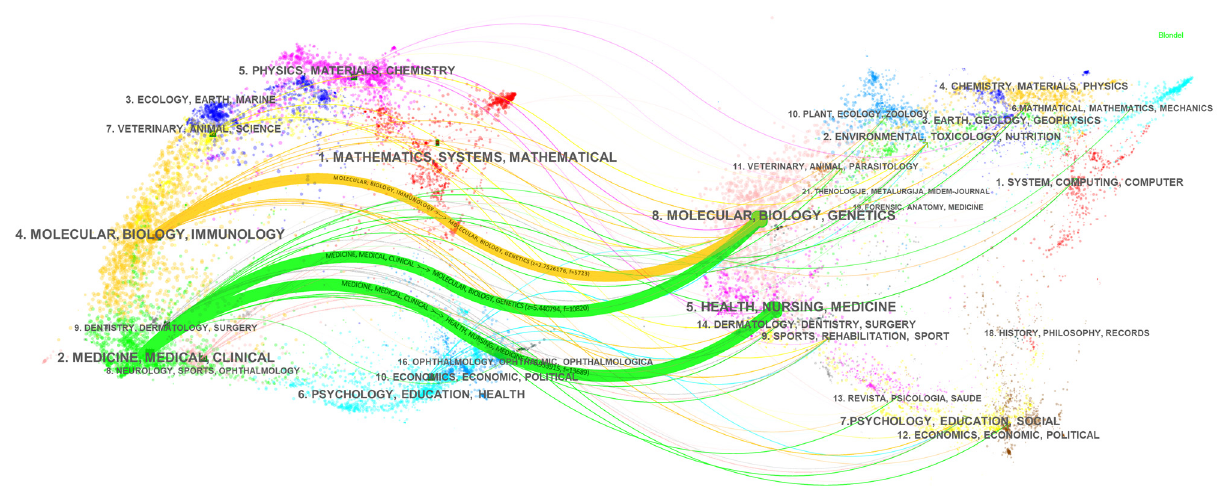
Figure 5. The dual-map overlay of citing journals on the left side and cited journals on the right.